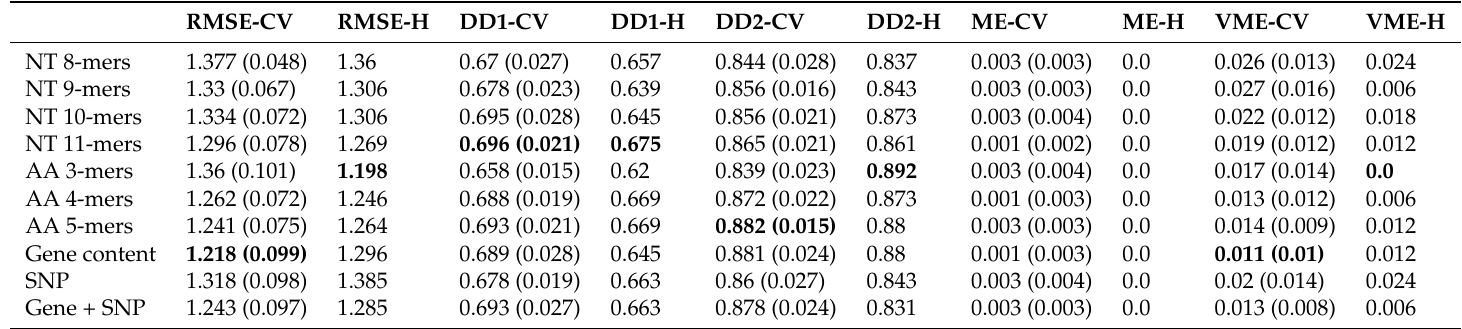
Table A48. K. pneumoniae